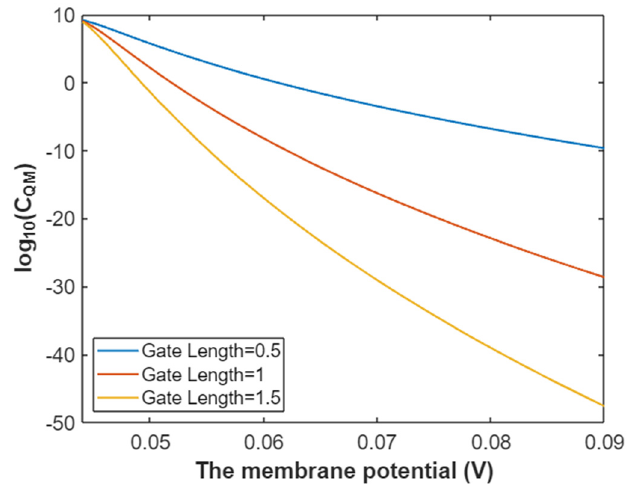
Figure 29. The relationship between membrane potential and the common logarithm of the quantum membrane conductance of extracellular potassium ions at G = 5.35 J and over a membrane potential range from 0.044 V to 0.09 V.